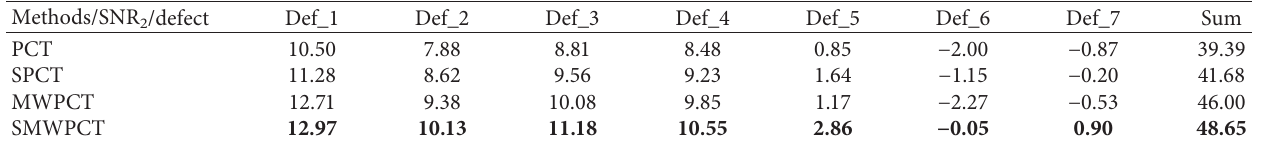
Table 2: SNR 2 of different methods.